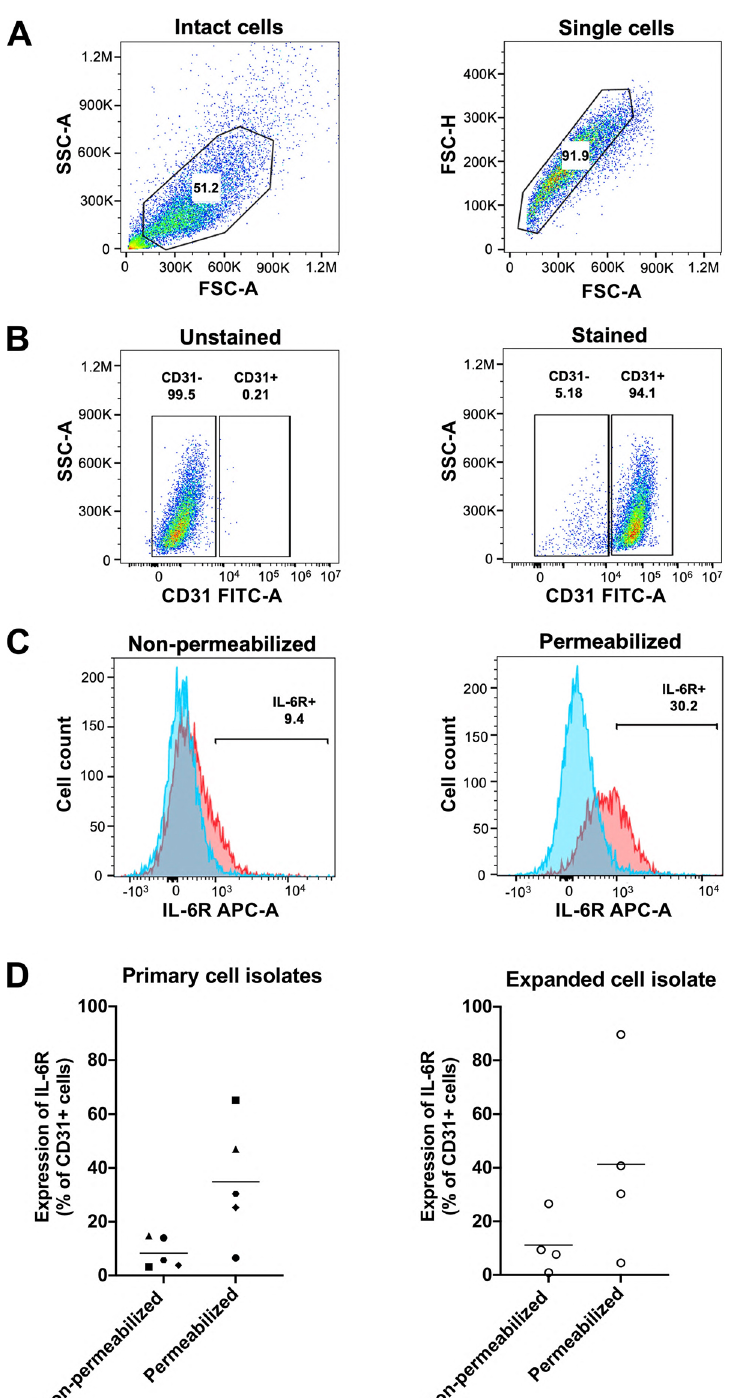
Fig. 2 IL-6R protein expression in human retinal endothelial cells. A‑C Representative flow cytometry plots from one cell isolate: ( A ) Debris and doublets were excluded based on forward scatter (FSC) and side scatter (SSC) properties. B CD31-positive were gated in each sample relative to unstained controls. C IL-6R expression was assessed in non-permeabilized and permeabilized CD31-positive cells. Blue and red traces indicate the fluorescence in unstained and IL-6R antibody-stained of CD31-positive cells, respectively. D Histograms showing percentage of CD31-positive cells expressing IL-6R for individual primary cell isolates ( n 5 donors) and the expanded cell isolate ( n 4 experiments). Bars indicate mean. = = Non-permeabilized and permeabilized groups were compared by donor-paired (primary cell isolates) and experiment-paired (expanded cell isolate) 2-tailed Student’s t-test: p >